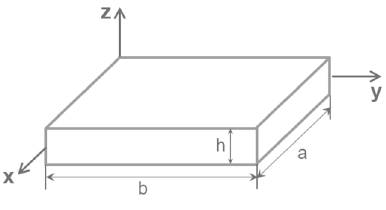
Figure 6. Plate geometry.